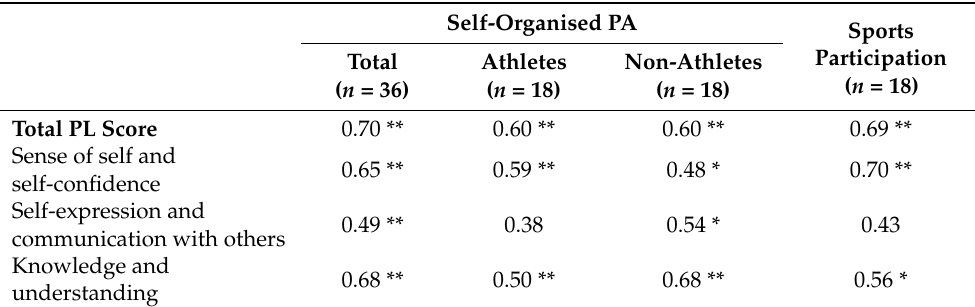
Table 2. Associations between perceived PL and participation in organised sports and self-organised physical activity.